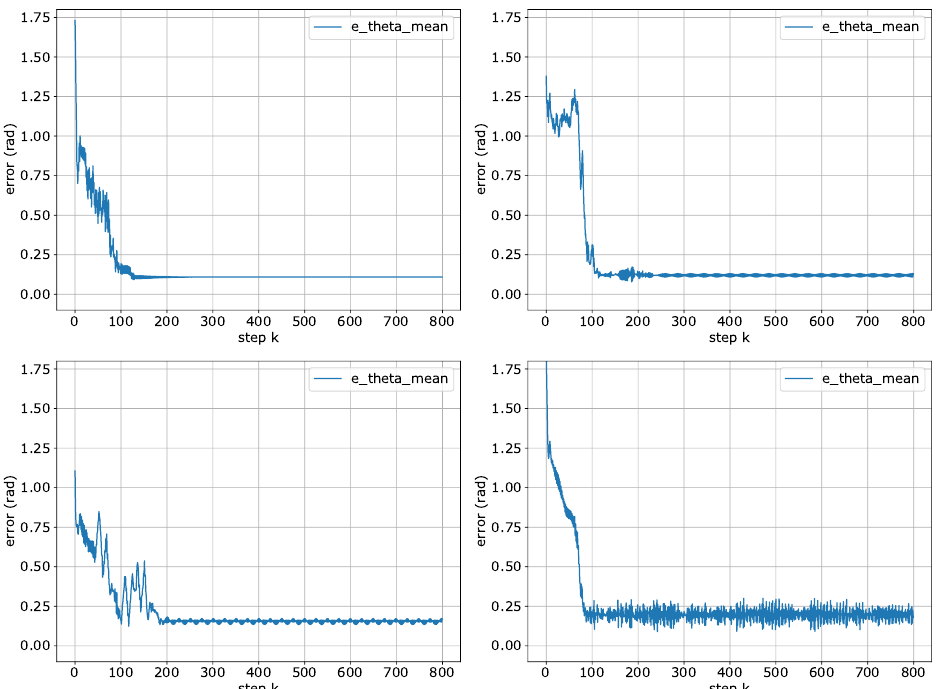
Figure 7. Error θ for example result for U control type, c 8 cost type, Gaussian White Noise Process, and δ =